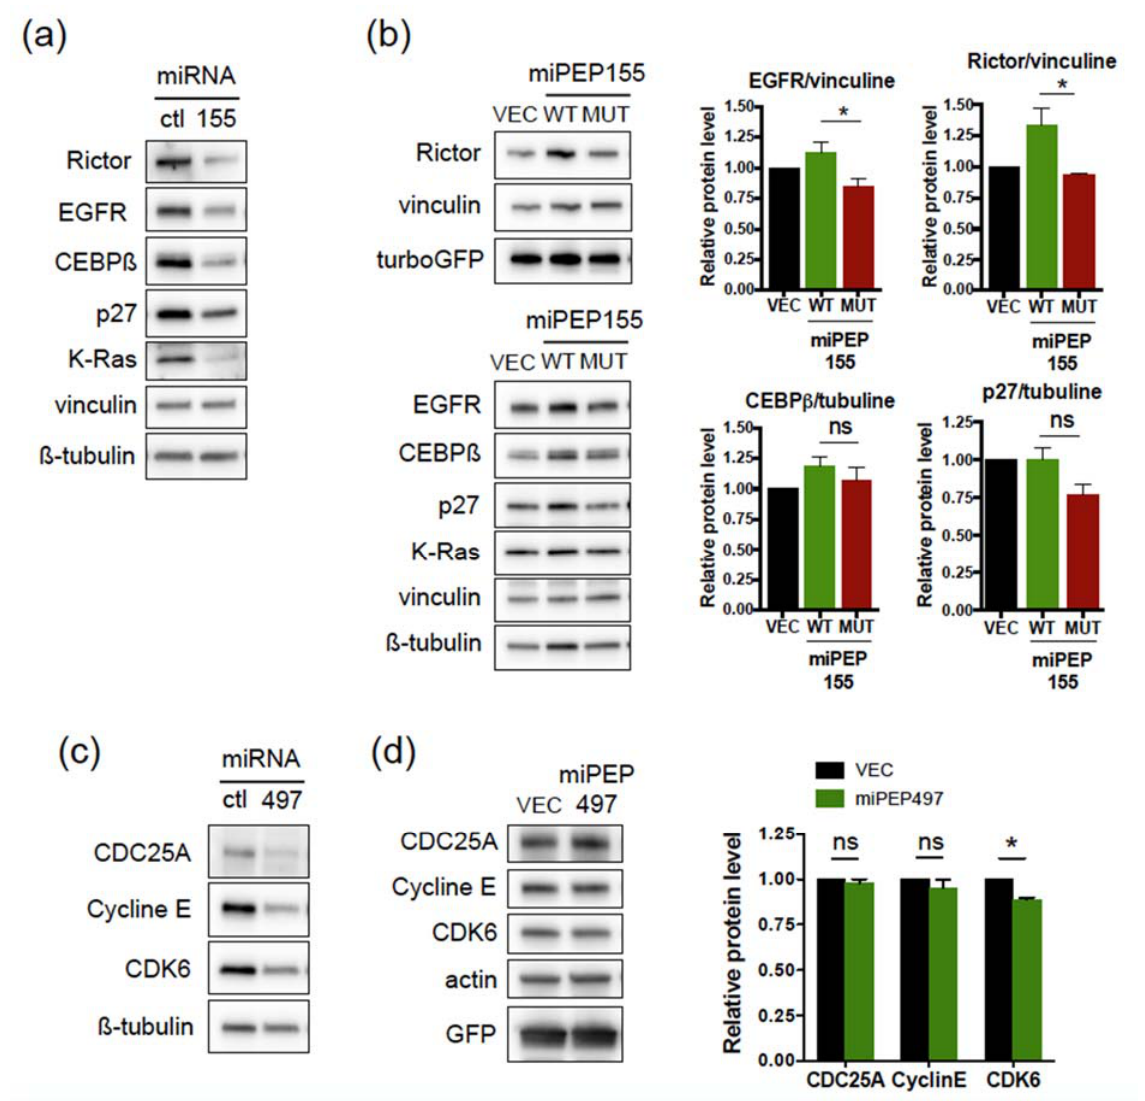
Figure 4. miPEP155 and miPEP497 do not regulate their corresponding miRNA target genes. ( a , b ) Hela cells transfected with control miRNA or miR-155 (9 nM) ( a ) or control vector or vectors expressing WT or mutated miPEP155 ( b , left panel) were analyzed by Western blots 48 h post-transfection using antibodies directed against the indicated proteins. Vinculin and ß-tubulin were used as loading controls. The vectors contain the turboGFP gene expressed from the same mRNA, used as control of transfection efficiency. ( c , d ) Hela cells transfected with control miRNA or miR-497 (10 nM) ( c ) or control vector or vector expressing miPEP497 ( d ) were analyzed 48 h post-transfection by Western blots using antibodies directed against the indicated proteins. Actin was used as loading control. The vectors contain the EGFP gene, used as control of transfection efficiency. ( b , d right panels) Quantification of the immunoblots. Data are means ± S.E.M. of four independent experiments. * p < 0.05. ns: not